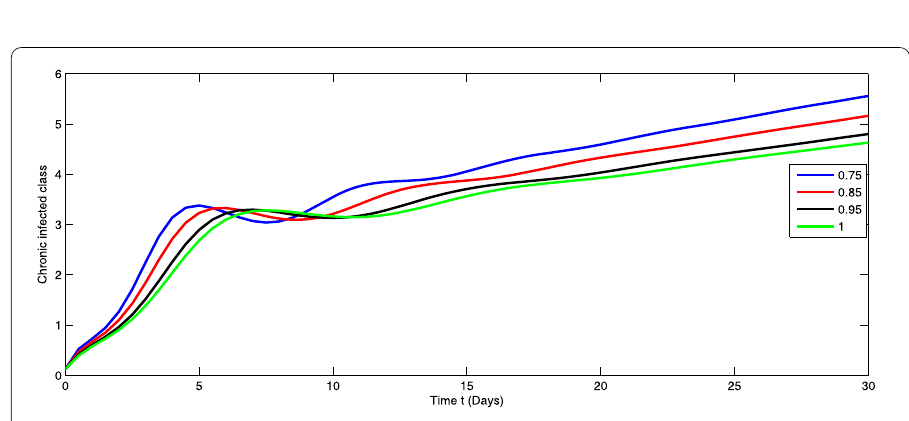
Figure 3 Graphical representation of the approximate solution C for the first ten terms at different fractional order